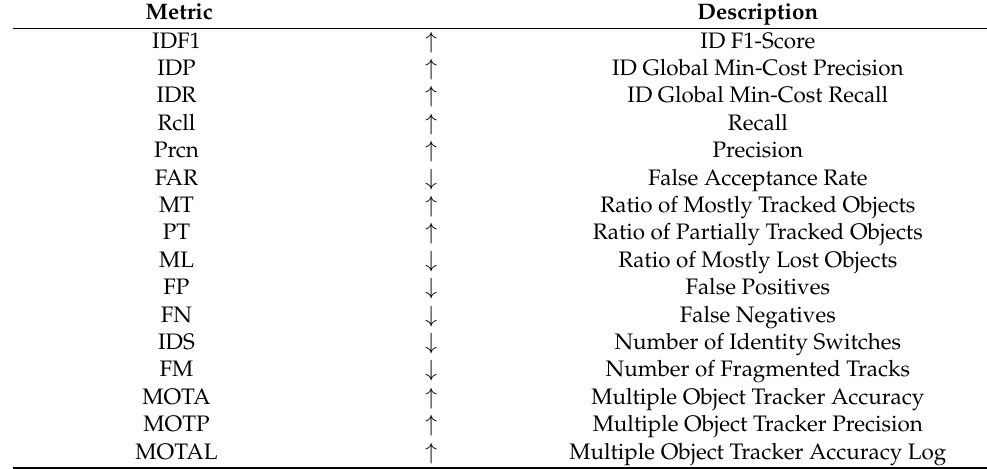
Table 4. Description of the metrics used for quantitative